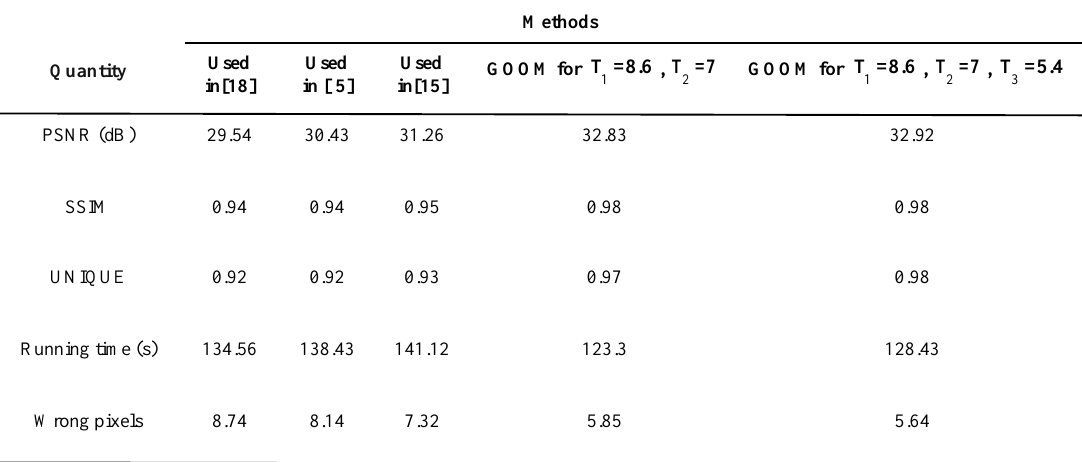
Figure 11. Virtual view synthesis by different methods for "Books" (a) used in [18] (b) used in [5] (c) used in [15] (d) the T =8.6 , T =7 (e) the proposed method for proposed method for 1 2 Table 7. Comparison of the proposed method with the other methods for